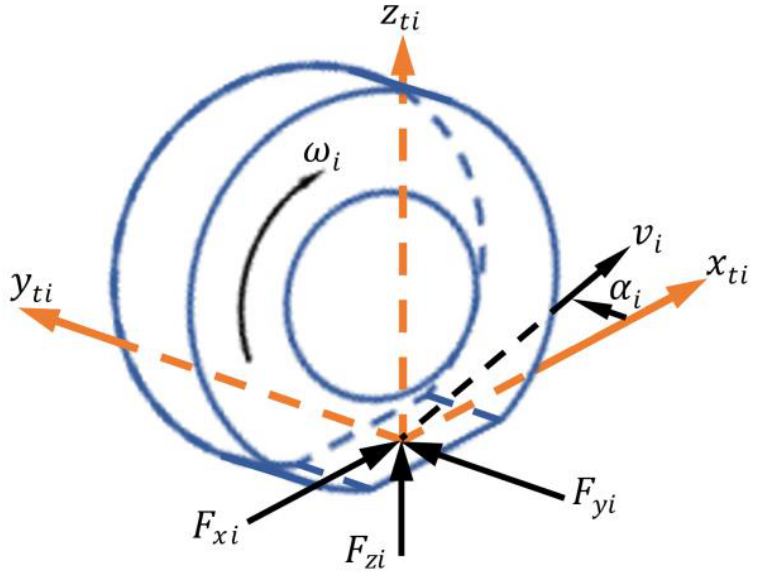
Figure 2. Tire coordinate system.